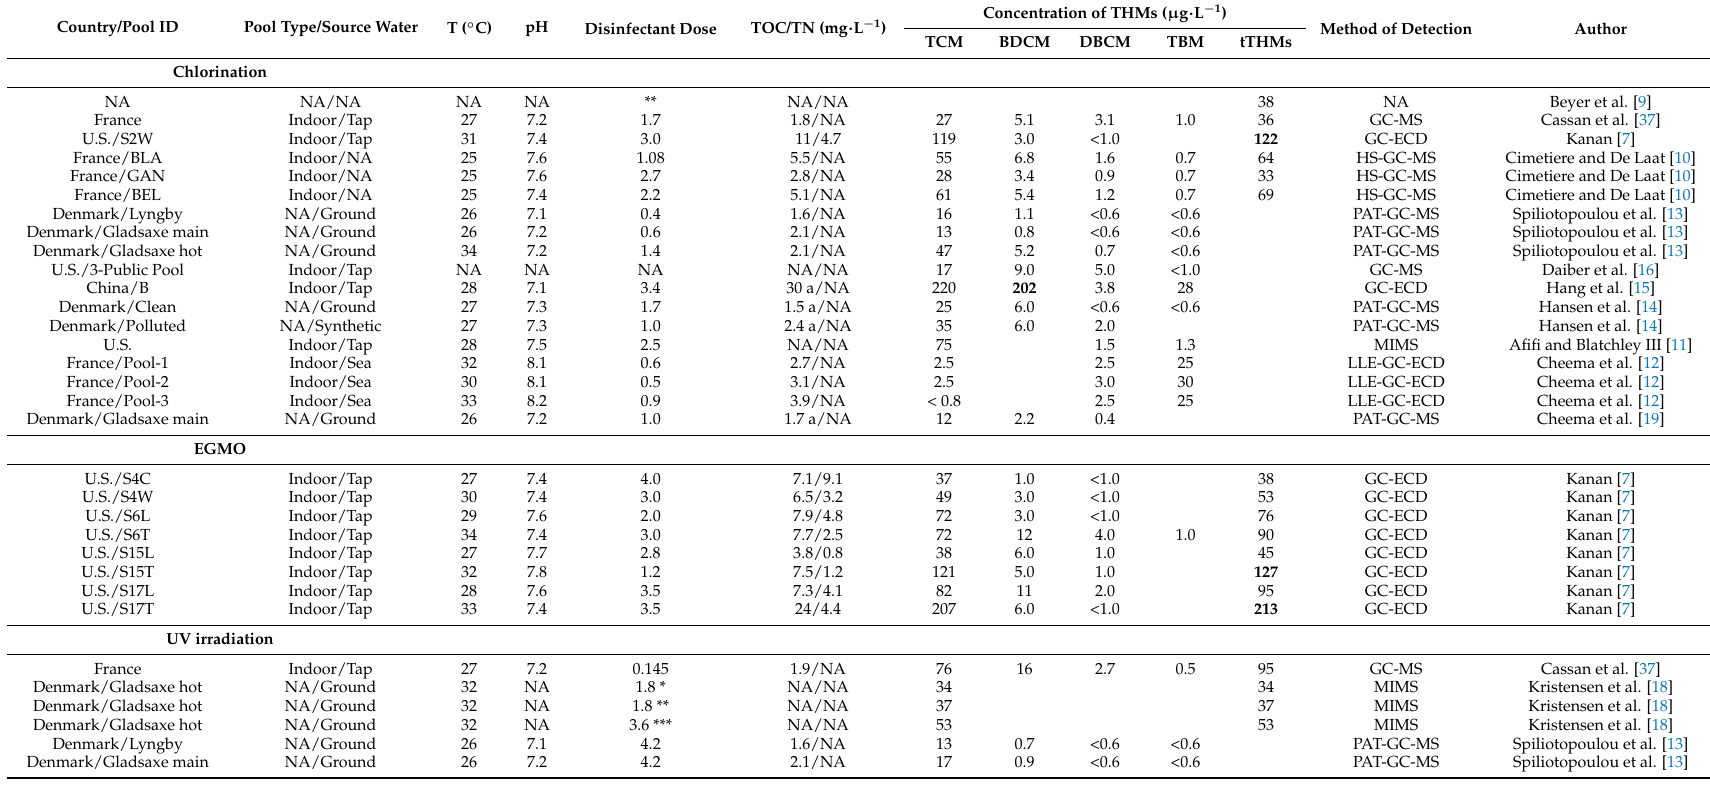
Table A3. Concentration of THMs with different disinfection